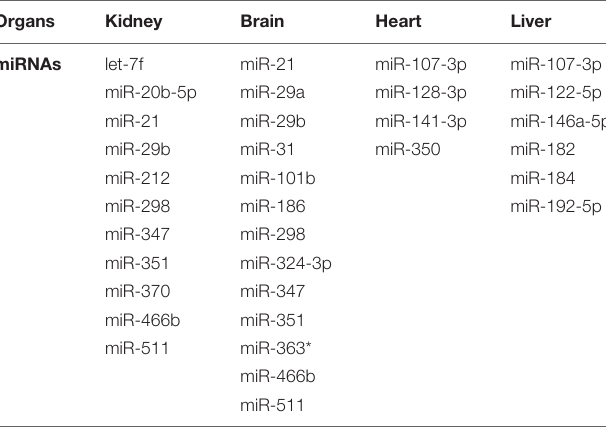
TABLE 5 | DOR-activation induced changes in miRNA expression profiles in normoxic condition. Organs Kidney Brain